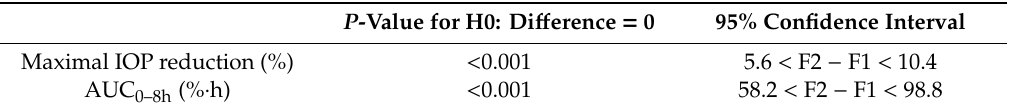
Table 6. Relationship between the two mean di ff erence test ( P -value of Student’s test) and confidence intervals for the di ff erence of the means. Formulation ACZ-VB and formulation ACZ-LP. P -Value for H0: Di ff erence = 0